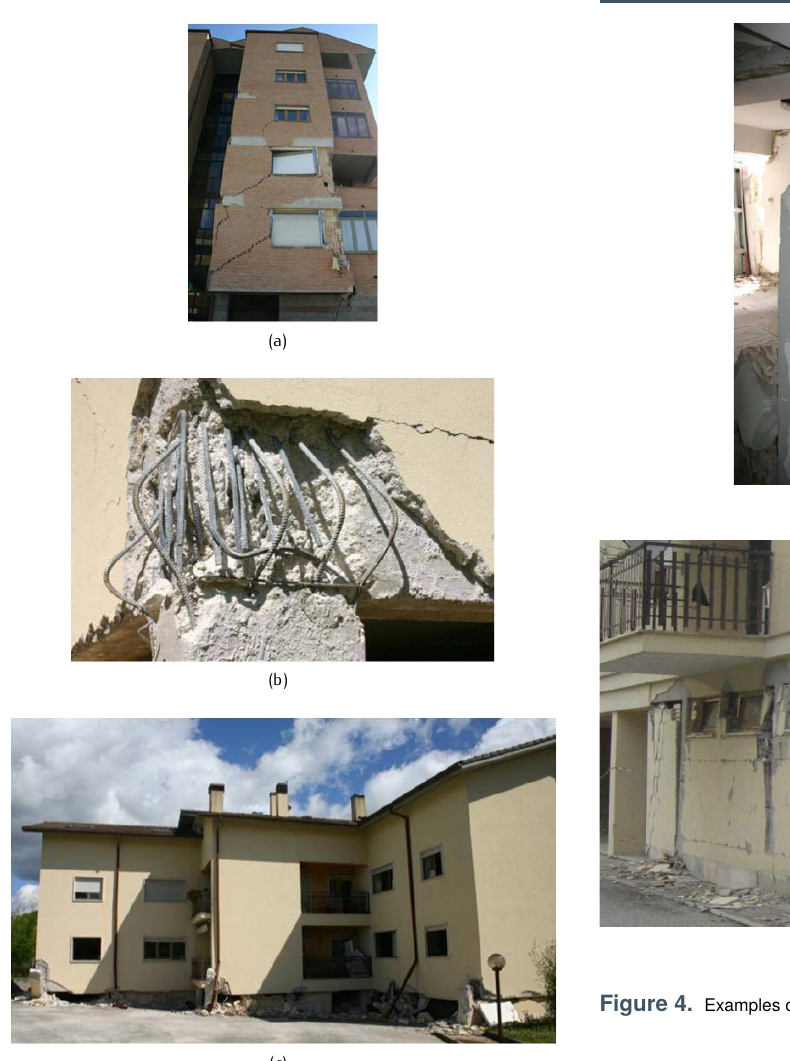
ement is modelled as the association of three-bar finite Figure 3. Damage on RC structures after the April 2009 L’Aquila elements, two with non-linear behaviour at its extremities, Earthquake: a) influence of infill masonry; b) inadequate and a central element with linear behaviour, as represented detailing of the joints; c) Formation of a soft and weak storey. in Figure 1. The non-linear monotonic behaviour curve of an element is characterized through a tri-linear force- distortion relationship. The hysteretic rules are controlled by three additional parameters, namely: α -stiffness degra- dation; β -“pinching” effect; and, γ -strength